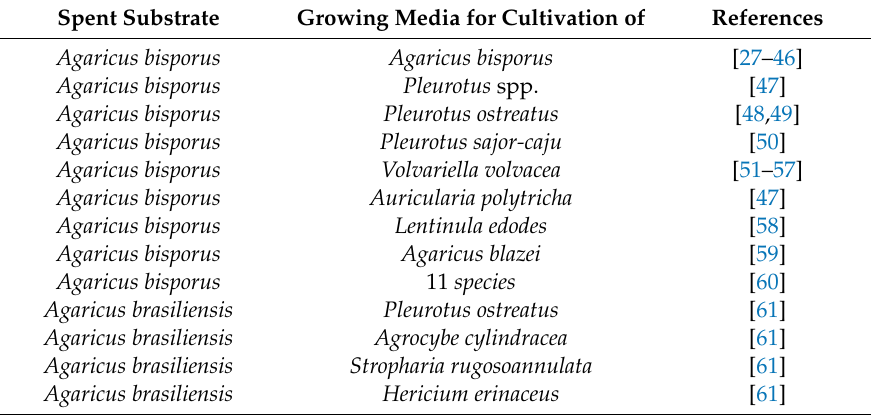
Table 1. Reuse of SMS of Agaricus spp. in new substrate